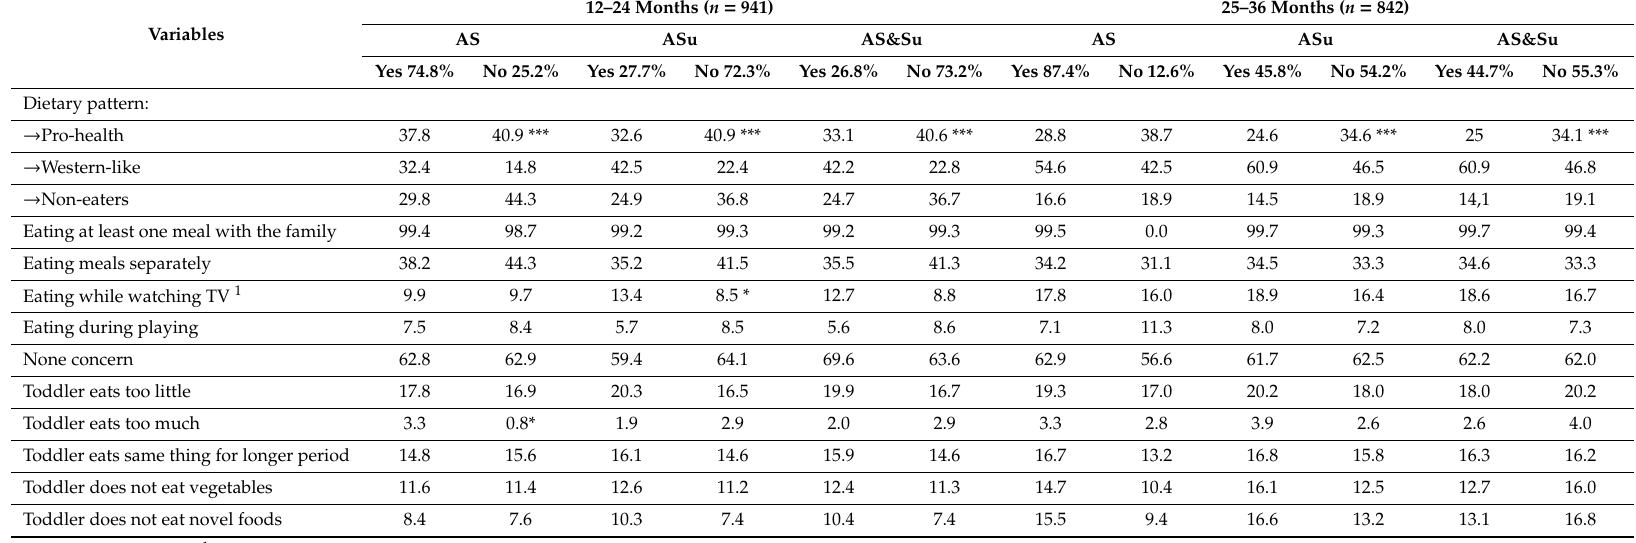
Table 5. Current toddlers’ dietary habits and maternal concerns about toddlers’ feeding according to the age group and use of added salt, sugar, and both salt and sugar in the Austrian sample ( n =